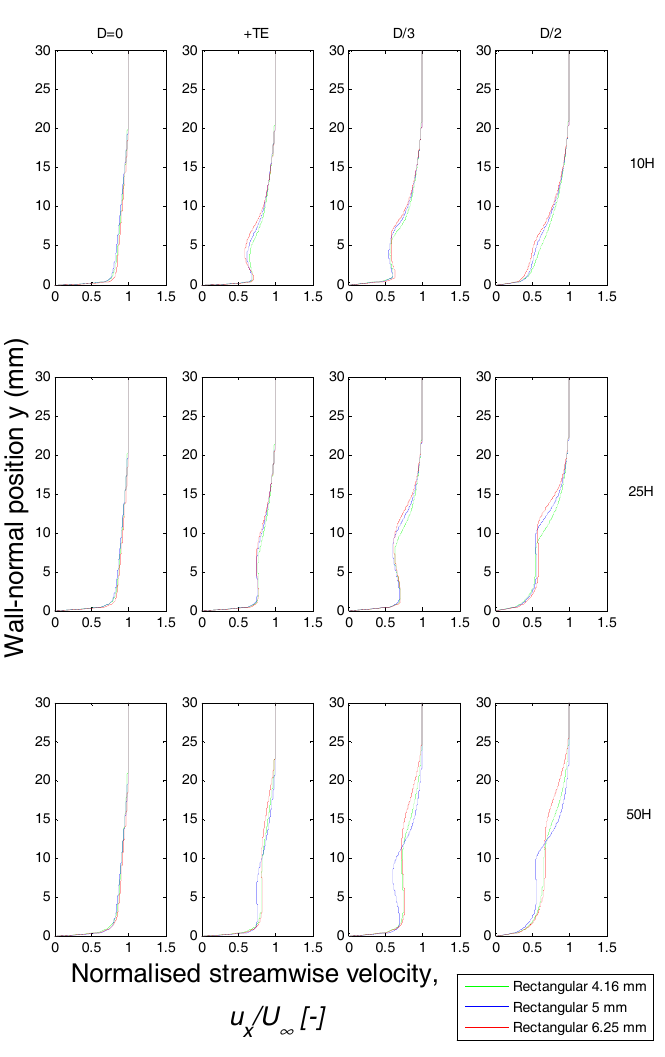
Figure 11. Normalized streamwise velocity ( u x / U ∞ ) profiles for the 4.16-mm, 5-mm and 6.25-mm VG heights at the 10H, 25H and 50H downstream positions.